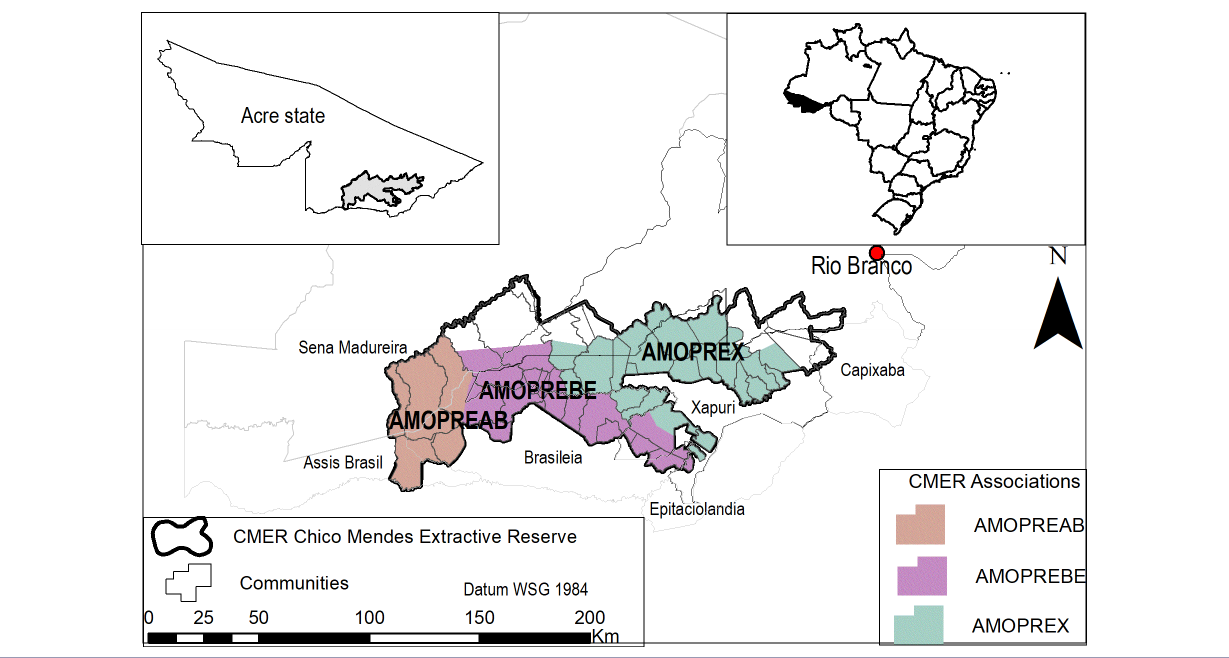
Fig. 1 . Community associations for workshops in the Chico Mendes Extractive Reserve in Acre,